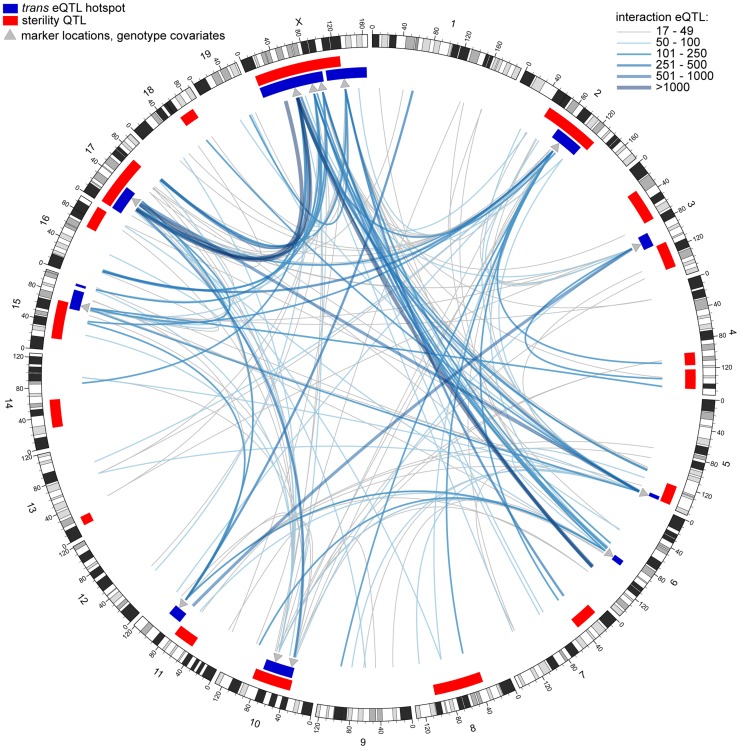
Genetic interactions revealed by conditional mapping.Genome plot generated using circos software [106]. Each line represents an interaction eQTL hotspot; color and thickness indicate number of eQTL. Red rectangles indicate sterility QTL positions and dark blue rectangles indicate trans eQTL hotspots (original mapping). Grey triangles indicate positions of marker genotypes used as covariates in conditional mapping.